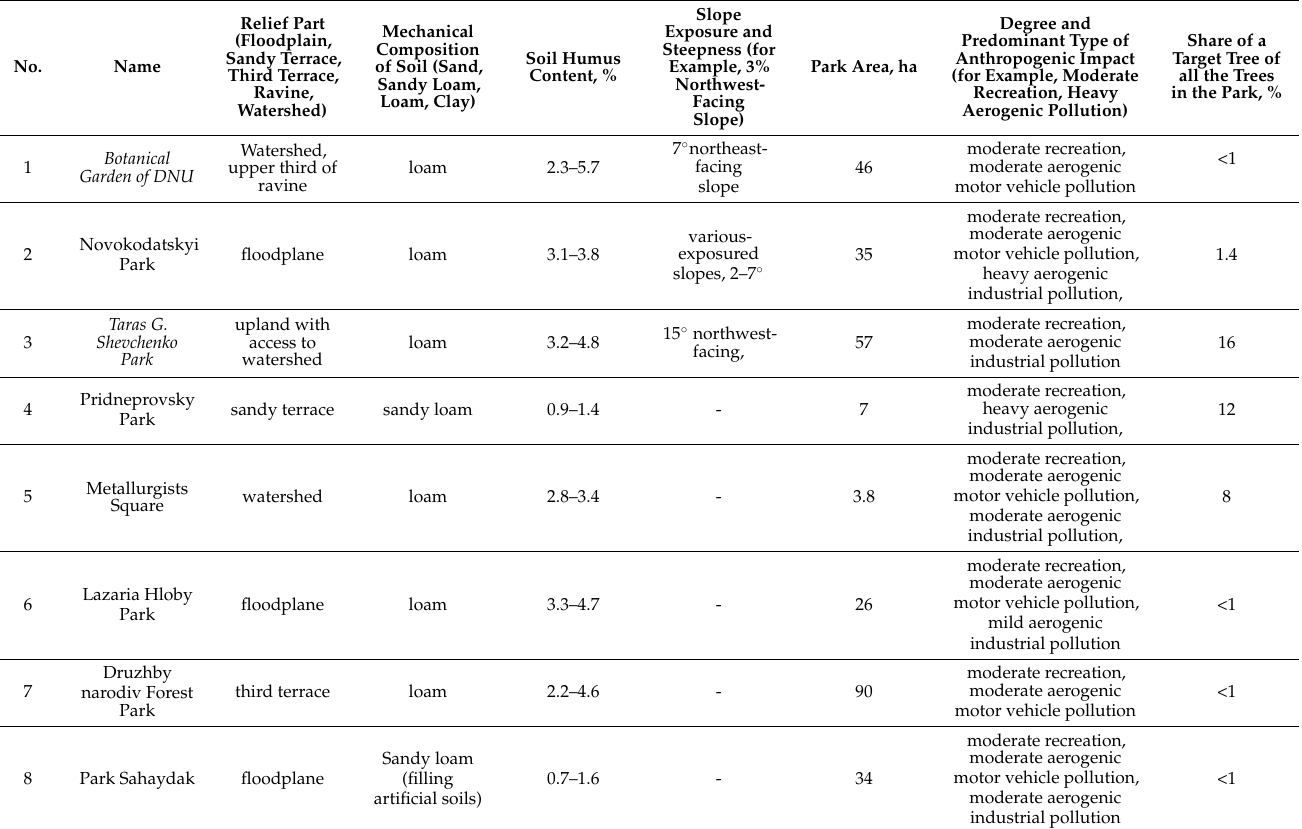
Table 2. Characteristics of the location of parks within the gradient of landscape and soil-climatic